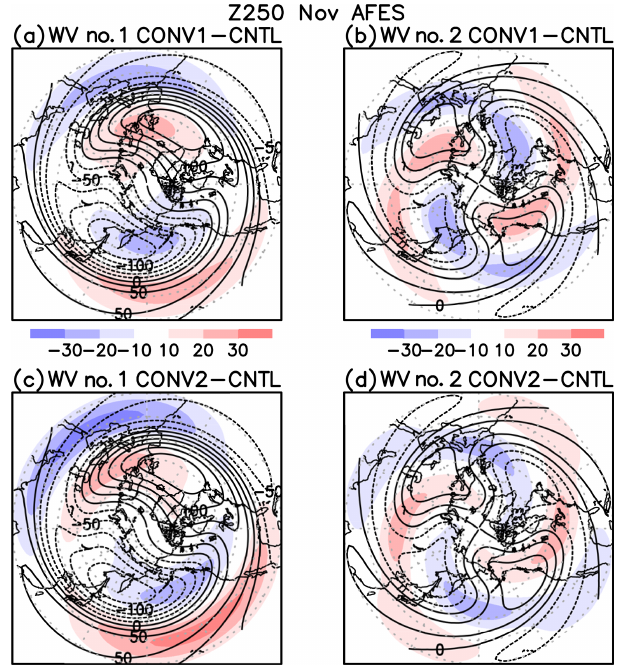
Figure 14. Wave-1 and -2 components of AGCM simulated re- sponse of geopotential height at 250hPa (Z250) in November. (a) Z250 wave-1 response to the adiabatic heating centered at 5 ◦ N, 150 ◦ E (shade). Contour shows the corresponding November cli- matological wave-1 field. Contour interval is 25m. (b) Same as panel (a) but for wavenumber 2. (c) Same as panel (a) but for a pair of adiabatic heating centered at 5 ◦ N, 150 ◦ E, and cooling centered at 5 ◦ N, 70 ◦ E. (d) Same as panel (c) but for wavenumber 2.